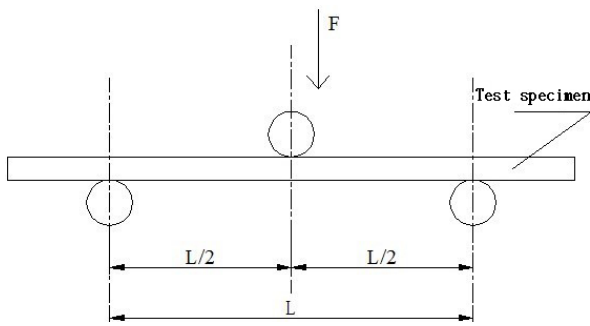
Figure 2. Three-point bending load test.